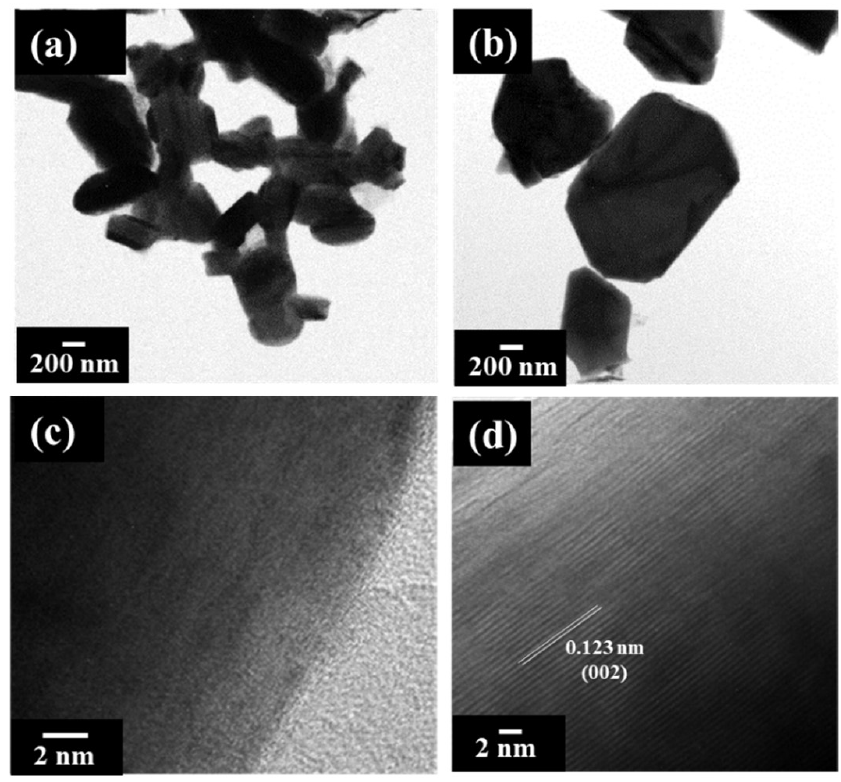
Figure 4. TEM images of the ( a ) NaCM- iB and ( b ) NaCM- f , HRTEM images of the ( c ) NaCM- iB and ( d ) NaCM- f samples.